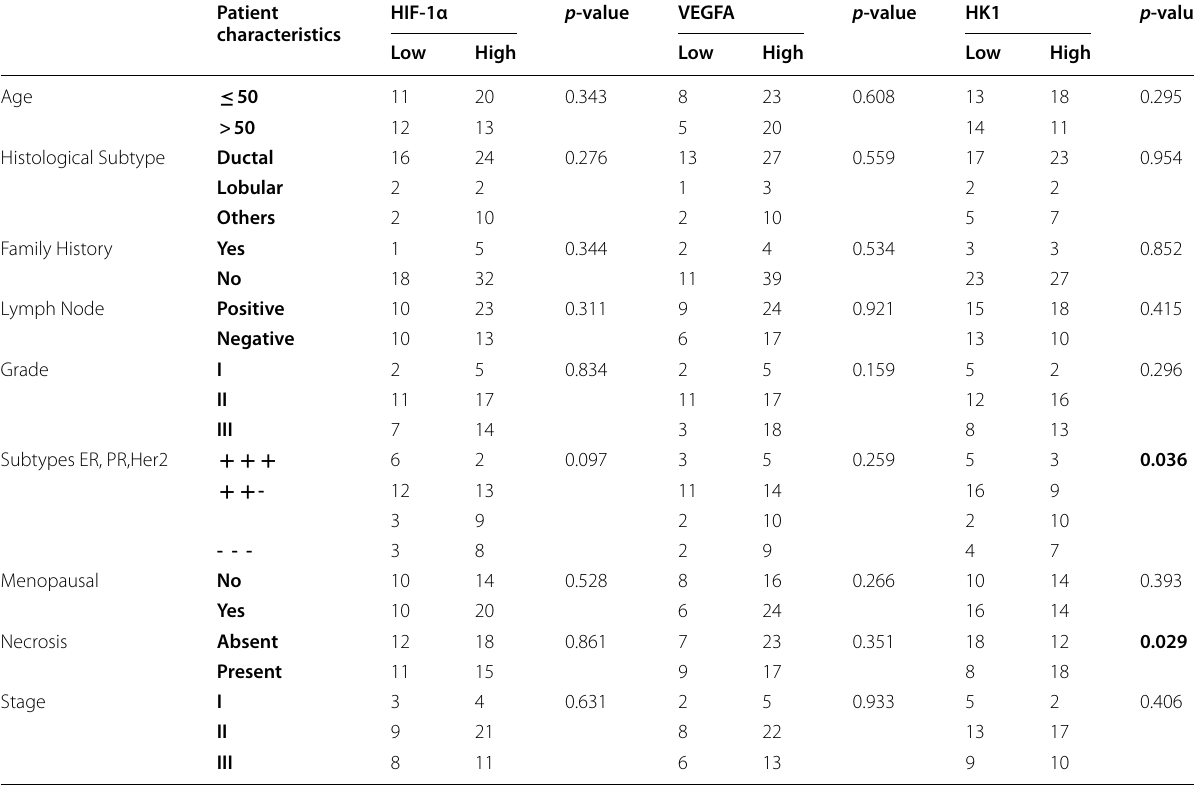
Table 2 Correlation coefficients between HIF-1α, VEGF-A and HK-I expression and clinicopathological parameters in breast